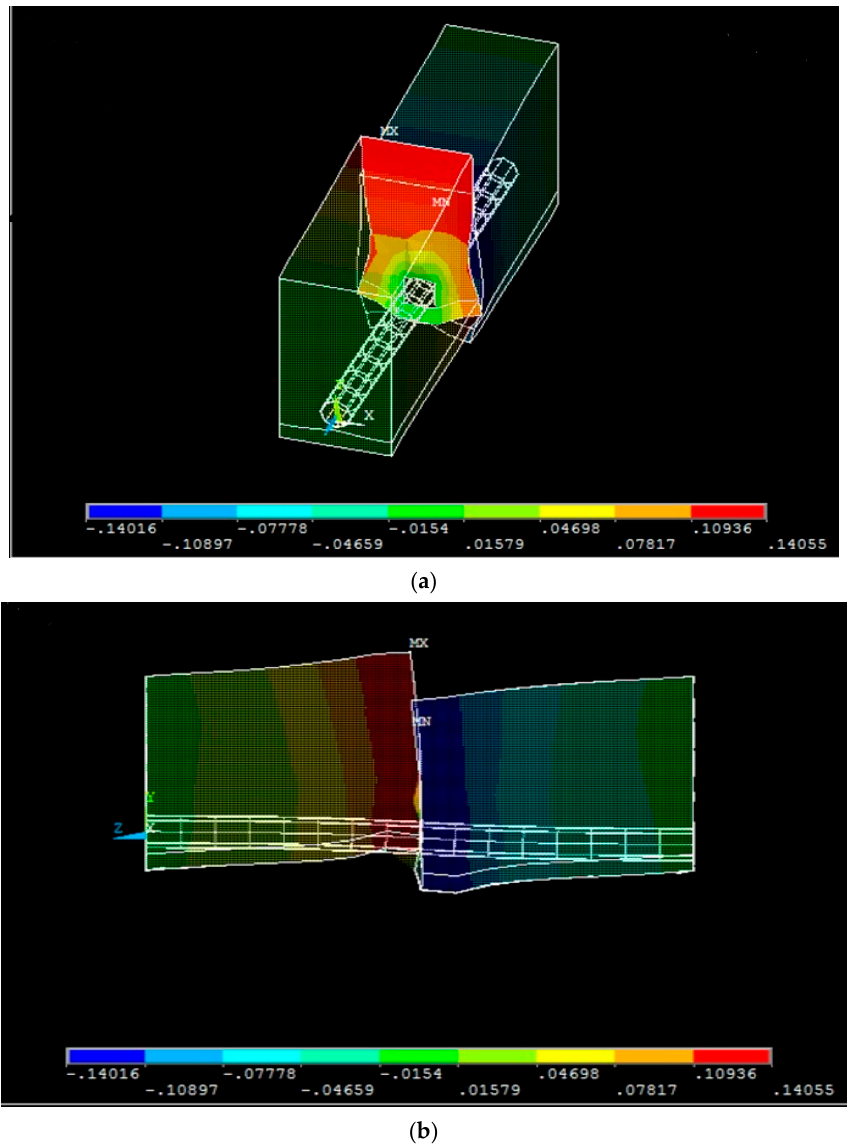
Figure 14. Typical soil and GPC pipe settlements under static loads ( a ) isometric view ( b ) side view.